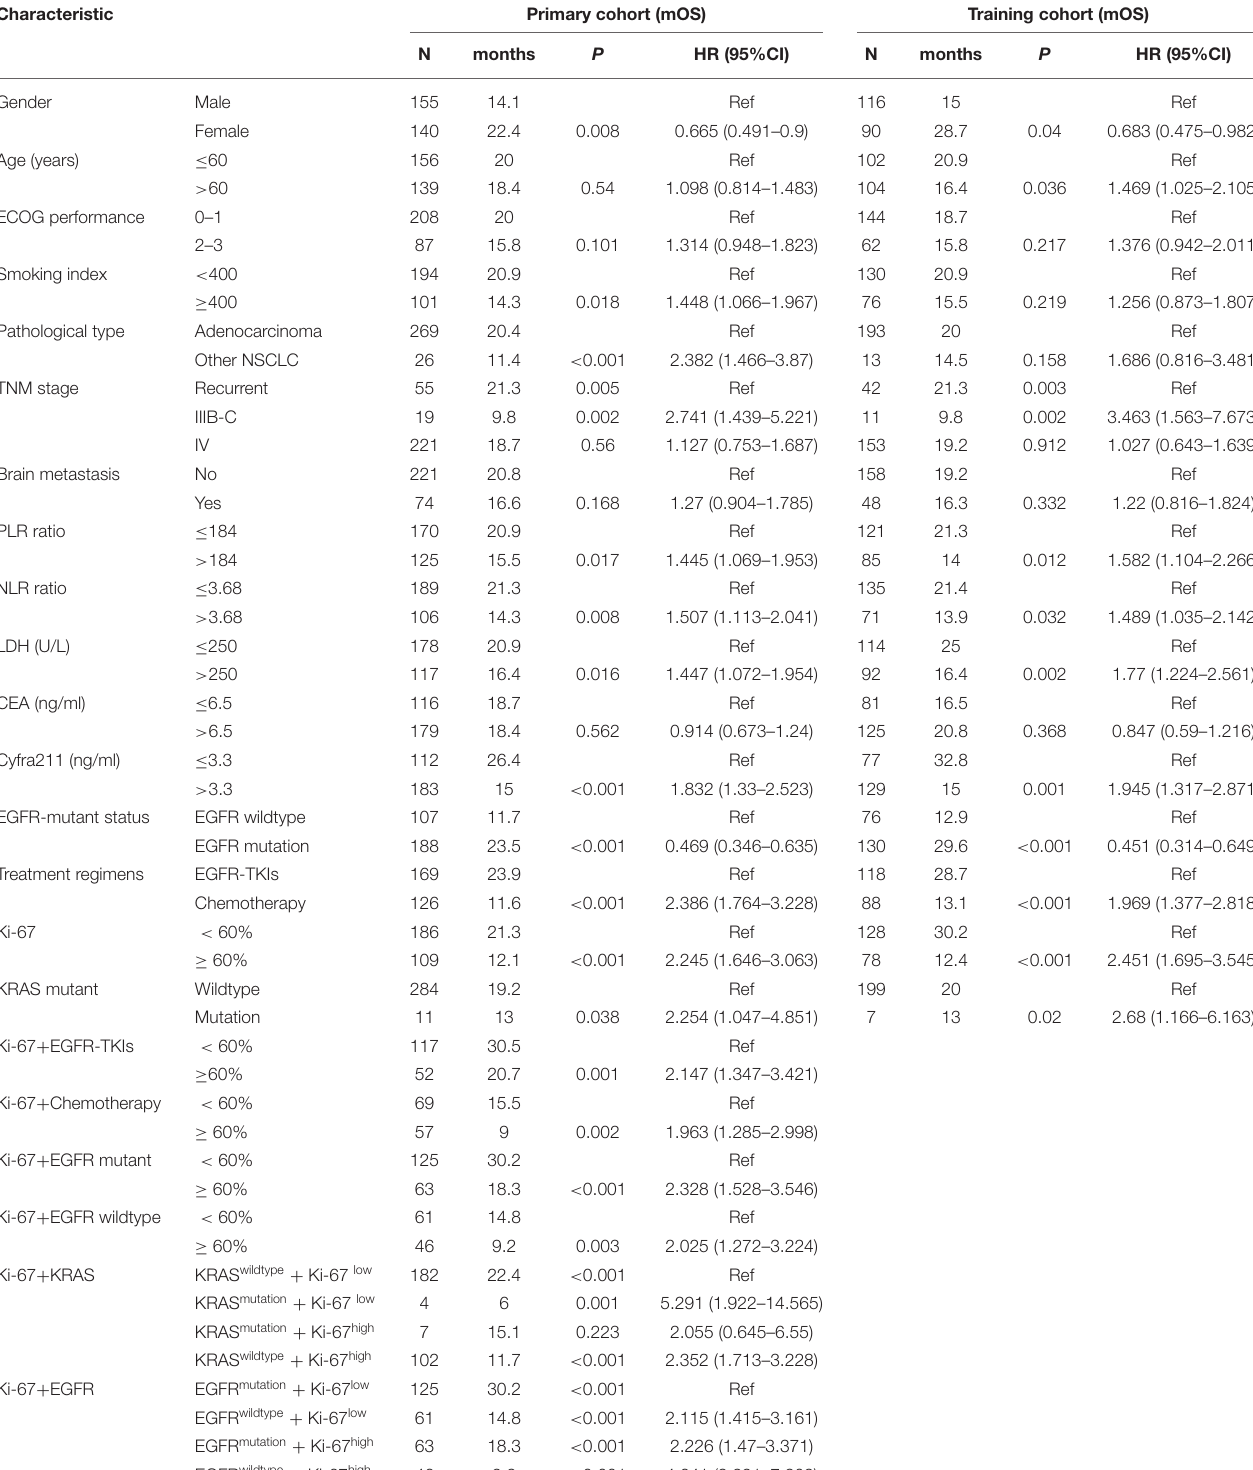
TABLE 2 | Univariate analysis of primary cohort and training cohort for first-line treatment in NSCLC.